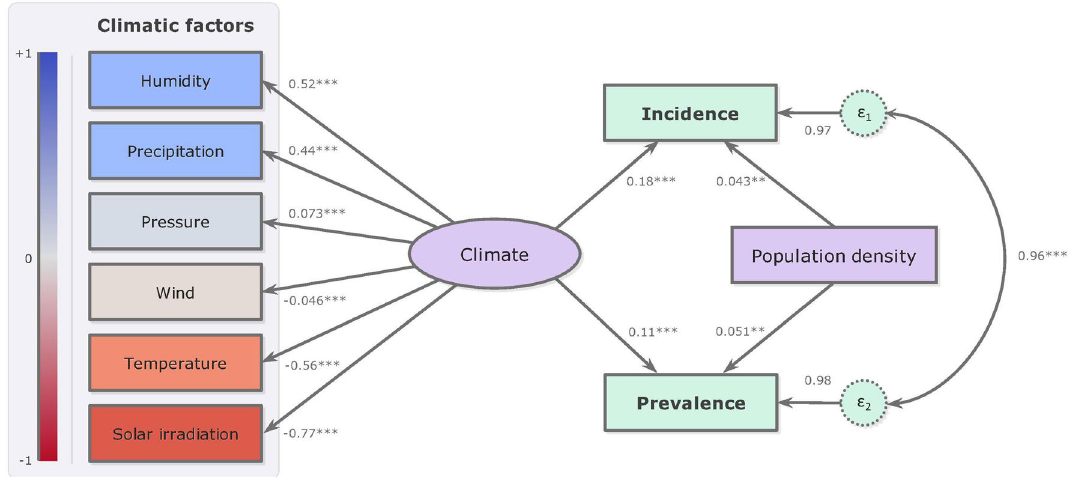
Figure 3. SEM path diagram for the effect of the climate and the population density on the spread of SARS- CoV-2. Observed variables are represented by boxes, latent variable by an ellipse, and residual terms by circles. The values on the straight arrows between latent and observed variables and those between latent and observed indicators represent the standardized path coefficients and the factors loading, respectively. The values on the straight arrows between residual terms and observed variables represent the residual variance. The diagram was generated using Office Power Point software for Microsoft 365 (https:// www. micro soft. com/ it- it/ micro soft- 365/ power point). ***p < 0.001; **p <